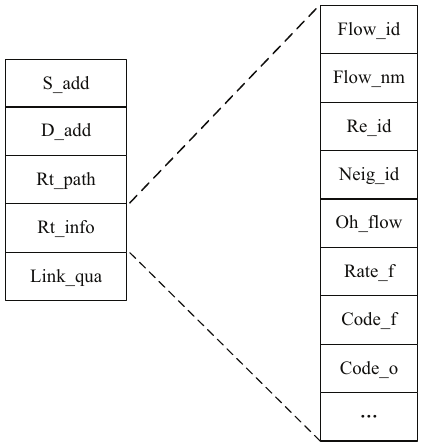
Figure 4. The format of the RREP message